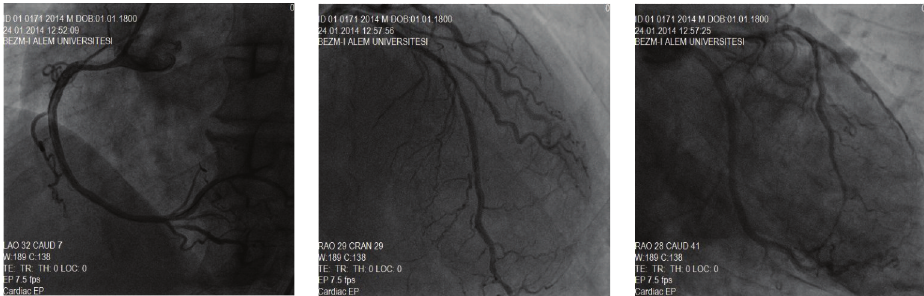
Figure 3: RCA and left system arteries after intracoronary nitroglycerin